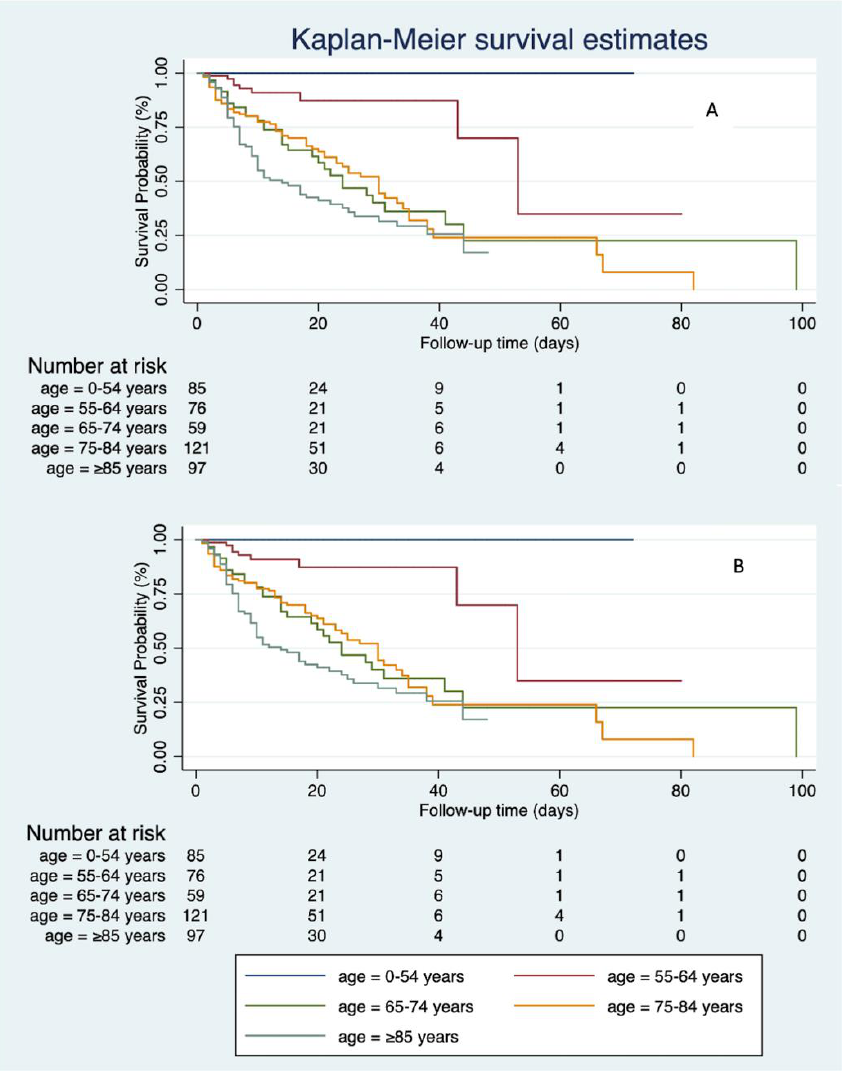
Figure 2. Kaplan – Meier survival estimates for SARS-CoV-2-infected patients divided by age group Figure 2. Kaplan–Meier survival estimates for SARS-CoV-2-infected patients divided by age group in the two periods: phase A ( A ) and phase B ( B ). in the two periods: phase A ( A ) and phase B ( B